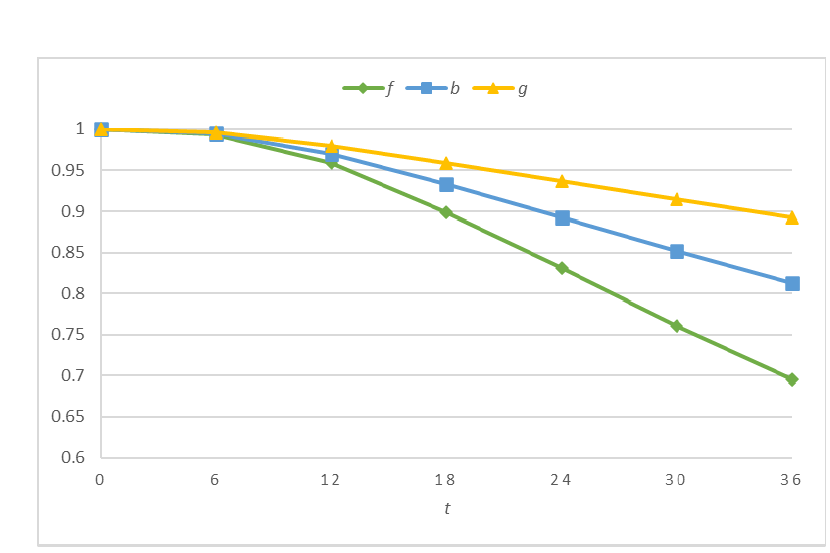
Figure 5. Effects of parameters 𝜇